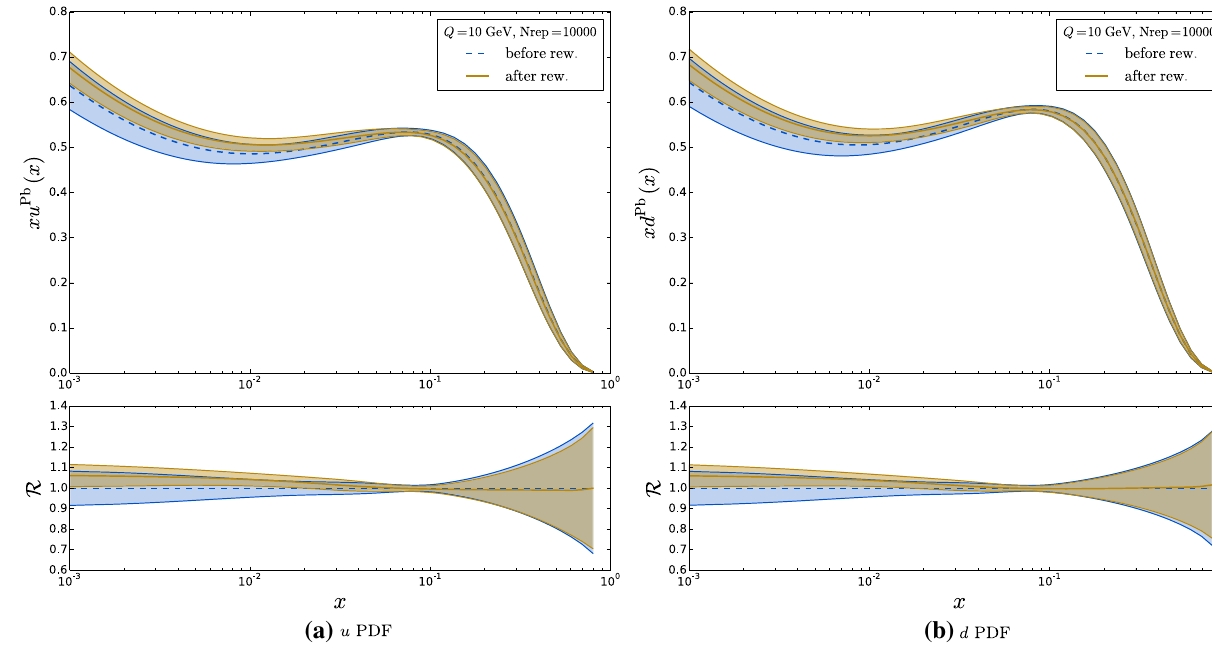
Fig. 27 u and d PDFs before and after the reweighting using all LHC pPb data sets